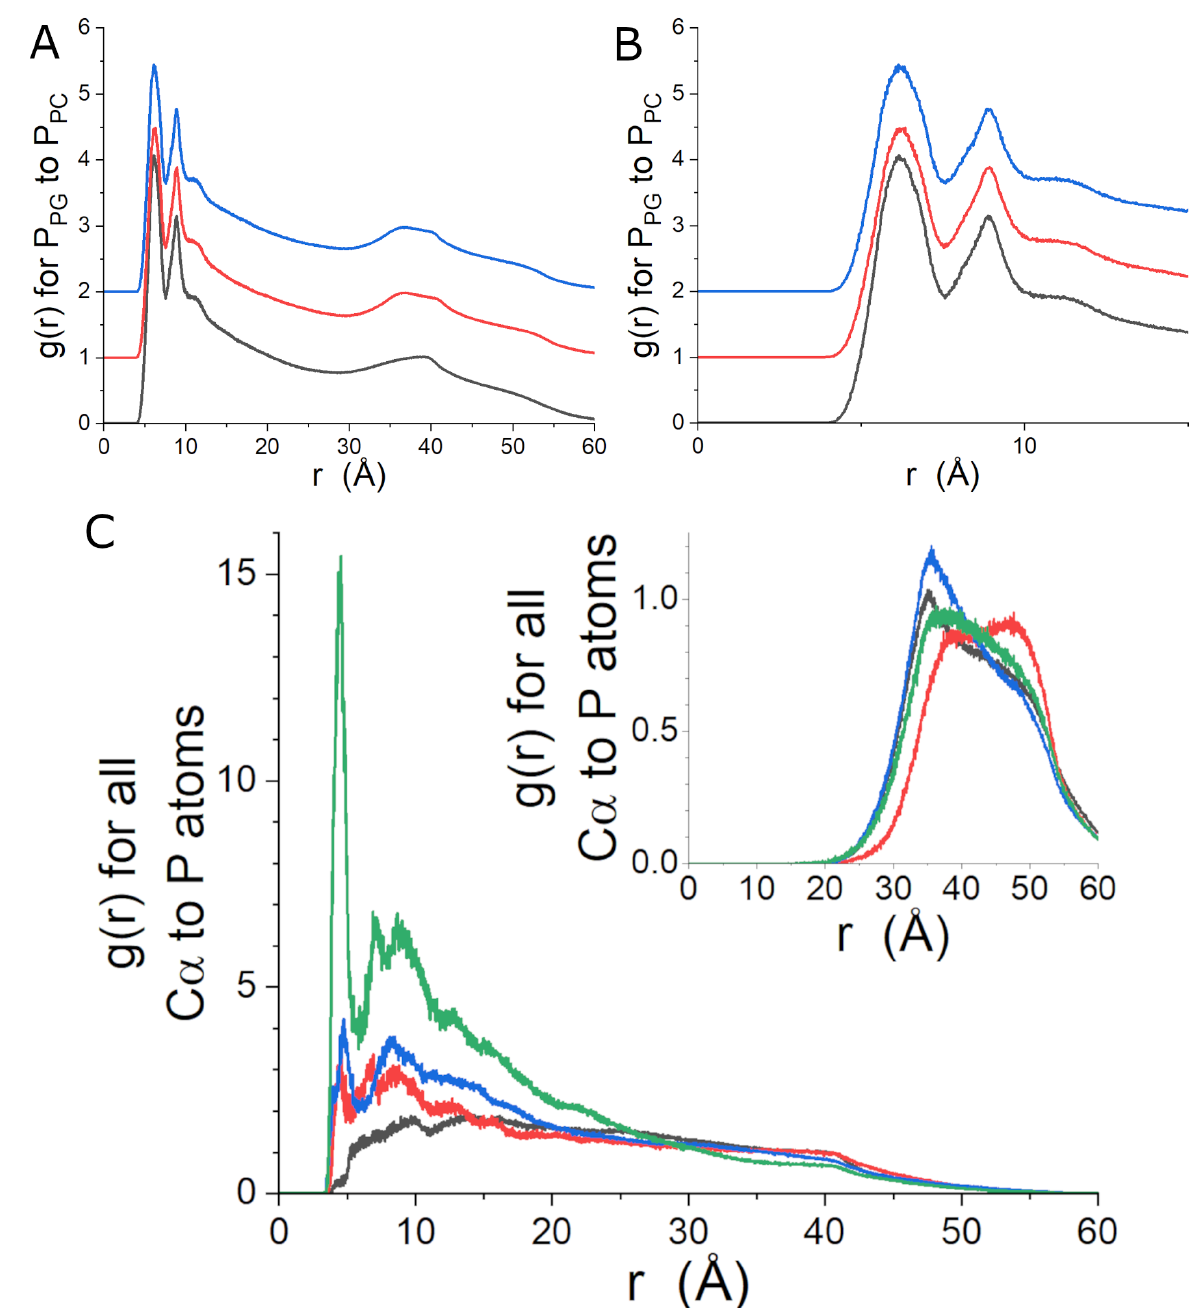
Figure 5. Phosphorous-to-phosphorous RDFs derived from the peptide-free MD simulations and the gp41rk/Lipid-3 simulation. The full-range ( A ) and magnified ( B ) results are shown. The curves are Lipid-1 (black), Lipid-2 (red) and Lipid-3 (blue). The curves in ( A , B ) have been offset for clarity. In ( C ), the RDFs for the protein C α to the four lipid P atoms are shown for lipids on the same side (main panel) and opposite side (inset panel) of the bilayer as gp41rk. The curves are DMPC (black), DMPG (red), POPC (blue) and POPG (green). The relative scaling of the RDFs in all three panels is as it was provided by the GROMACS tool